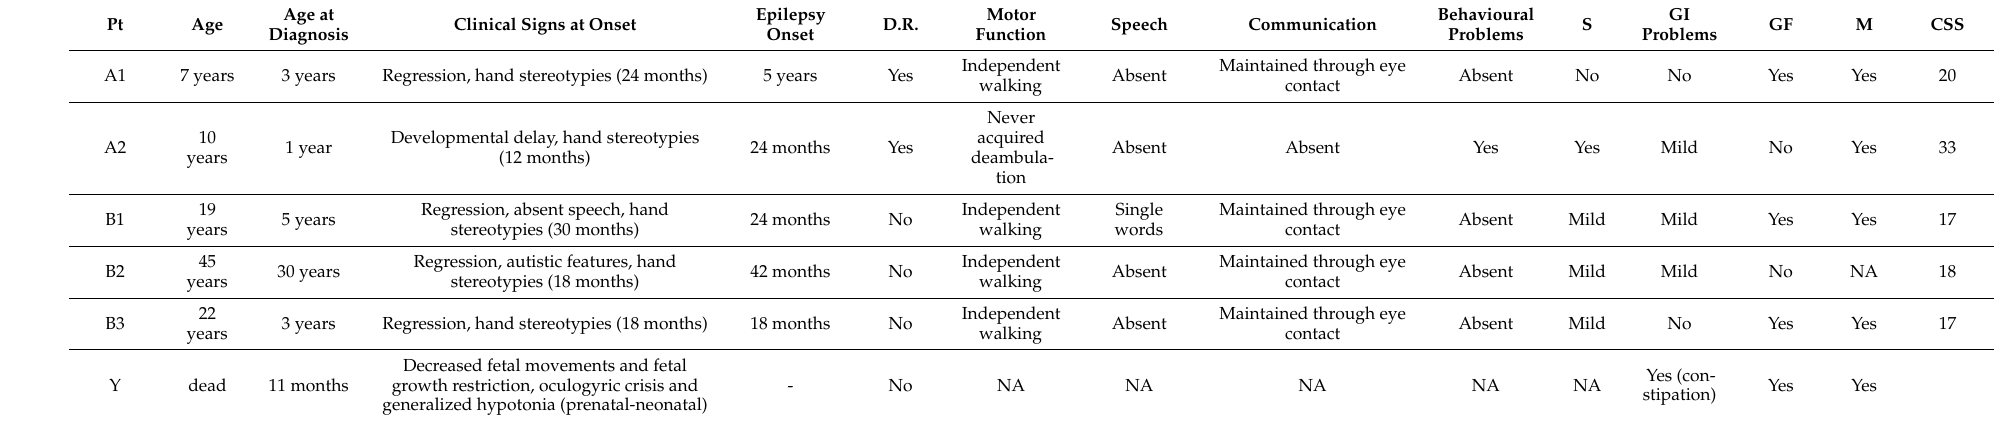
Table 1. Clinical features of patients included in the